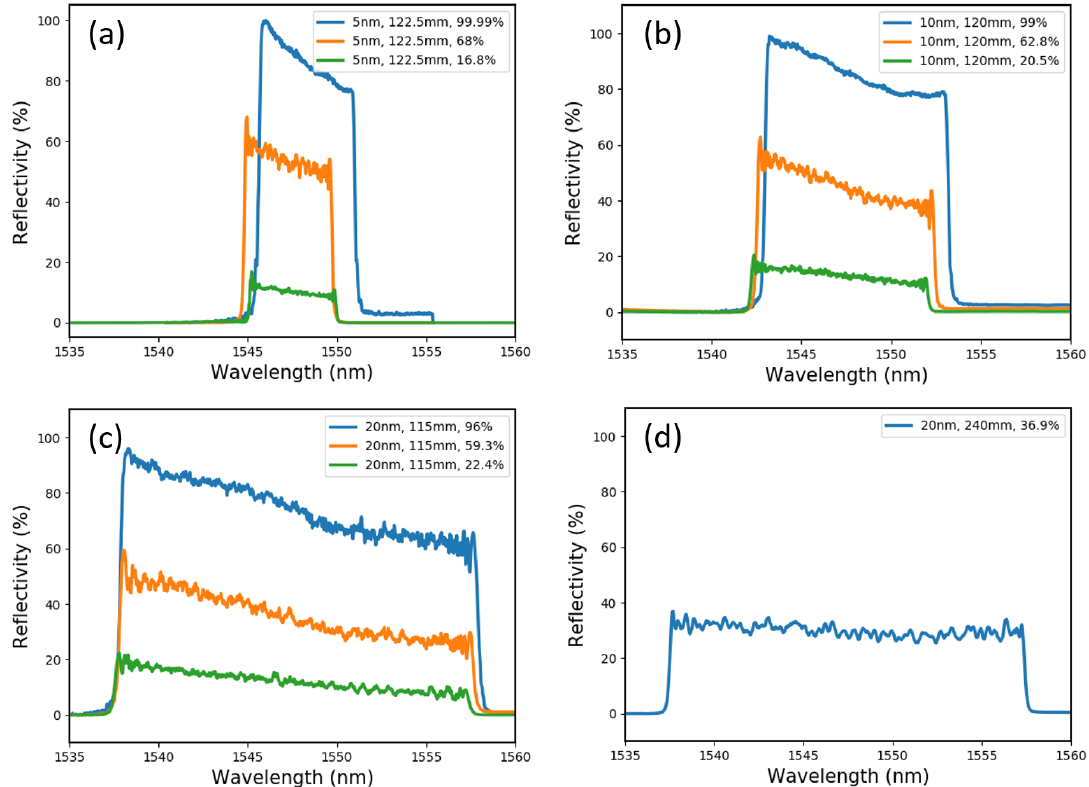
Figure 9. Grating spectra of the: ( a ) 5 nm bandwidth; ( b ) 10 nm bandwidth; ( c ) 20 nm bandwidth; and ( d ) 240 mm long CFBGs used in our detonation velocity